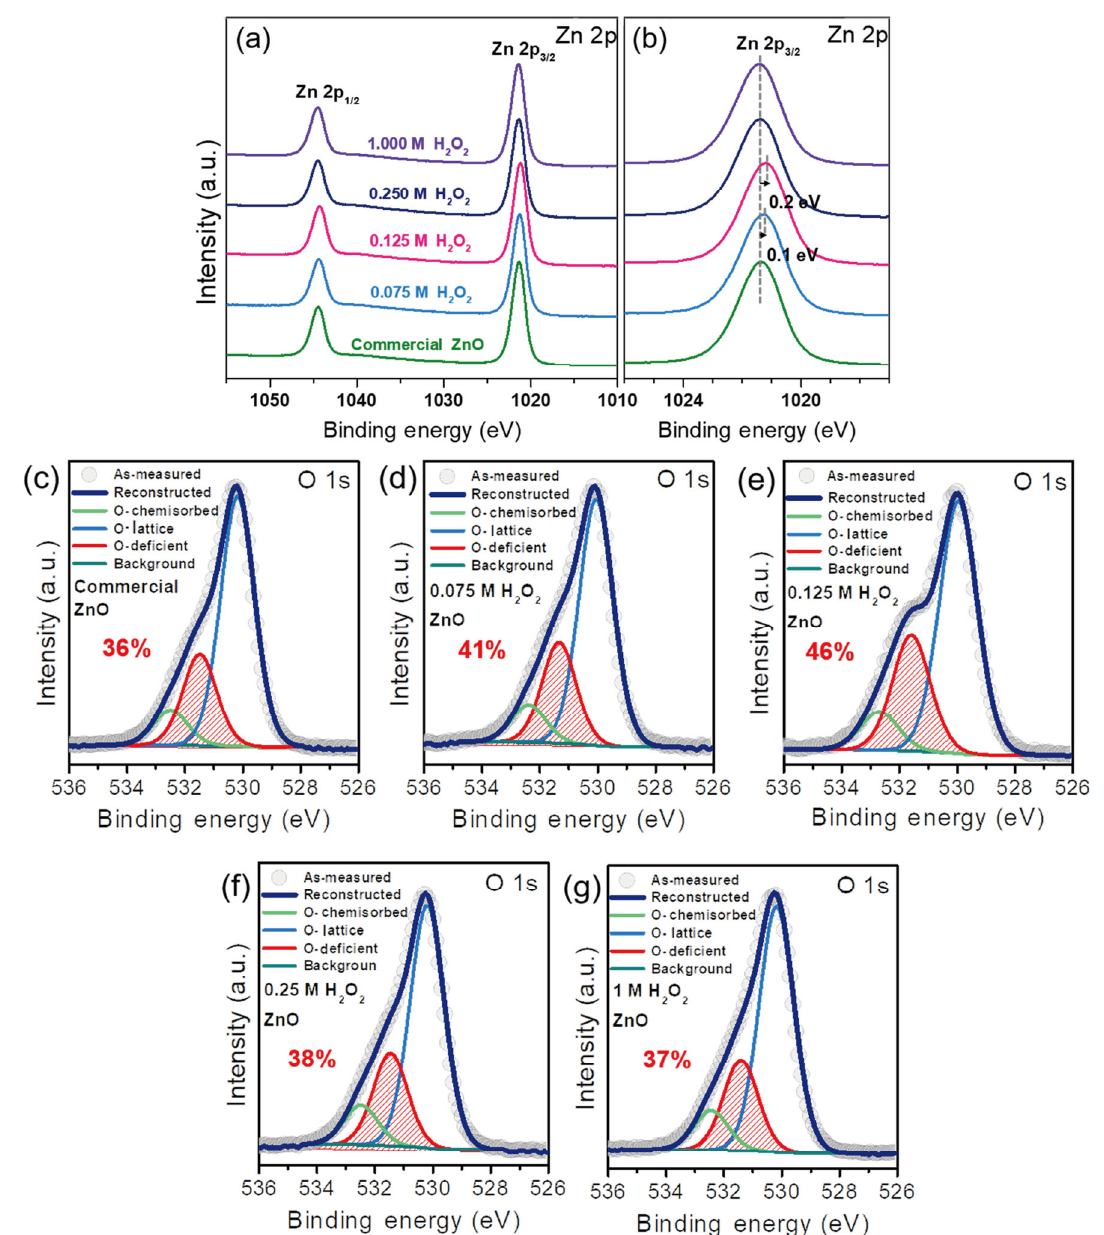
Fig. 6 (a) Zn 2p XPS spectra of commercial ZnO NPs and x M H 2 O 2 treated/annealed ZnO NPs ( x = 0.075, 0.125, 0.250, and 1.000); (b) Zn 2p 3/2 peaks of the samples; O 1s XPS spectra of (c) commercial ZnO NPs and (d–g) x M H 2 O 2